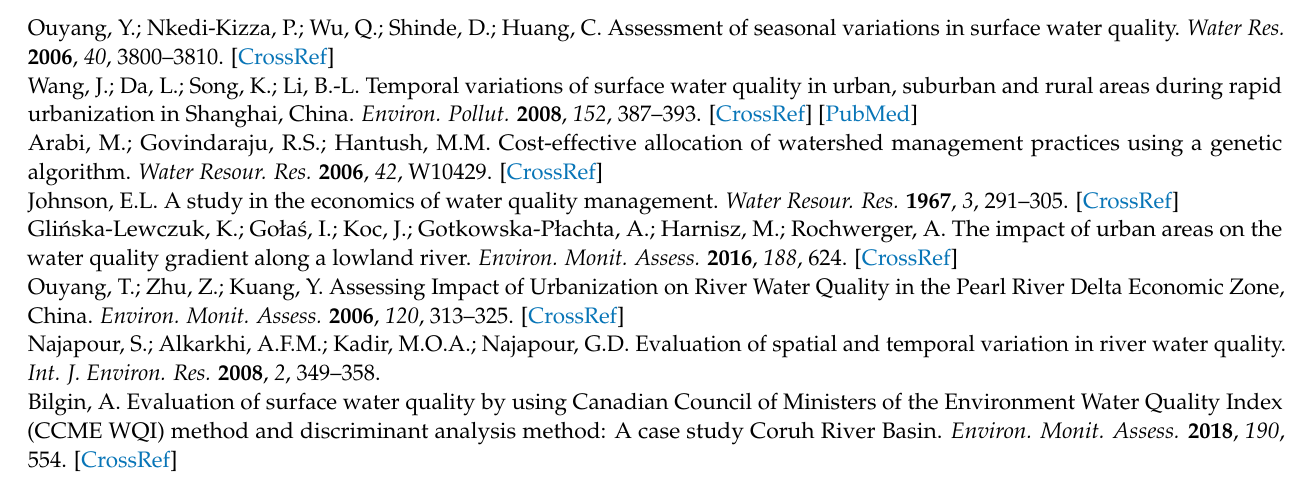
characteristics, Table S2: Information of analytical methods and instrument, Table S3: Water quality parameters and scores, Table S4: Information of water quality index, Table S5: Seven-year average value in the dry season and the wet season on monitoring